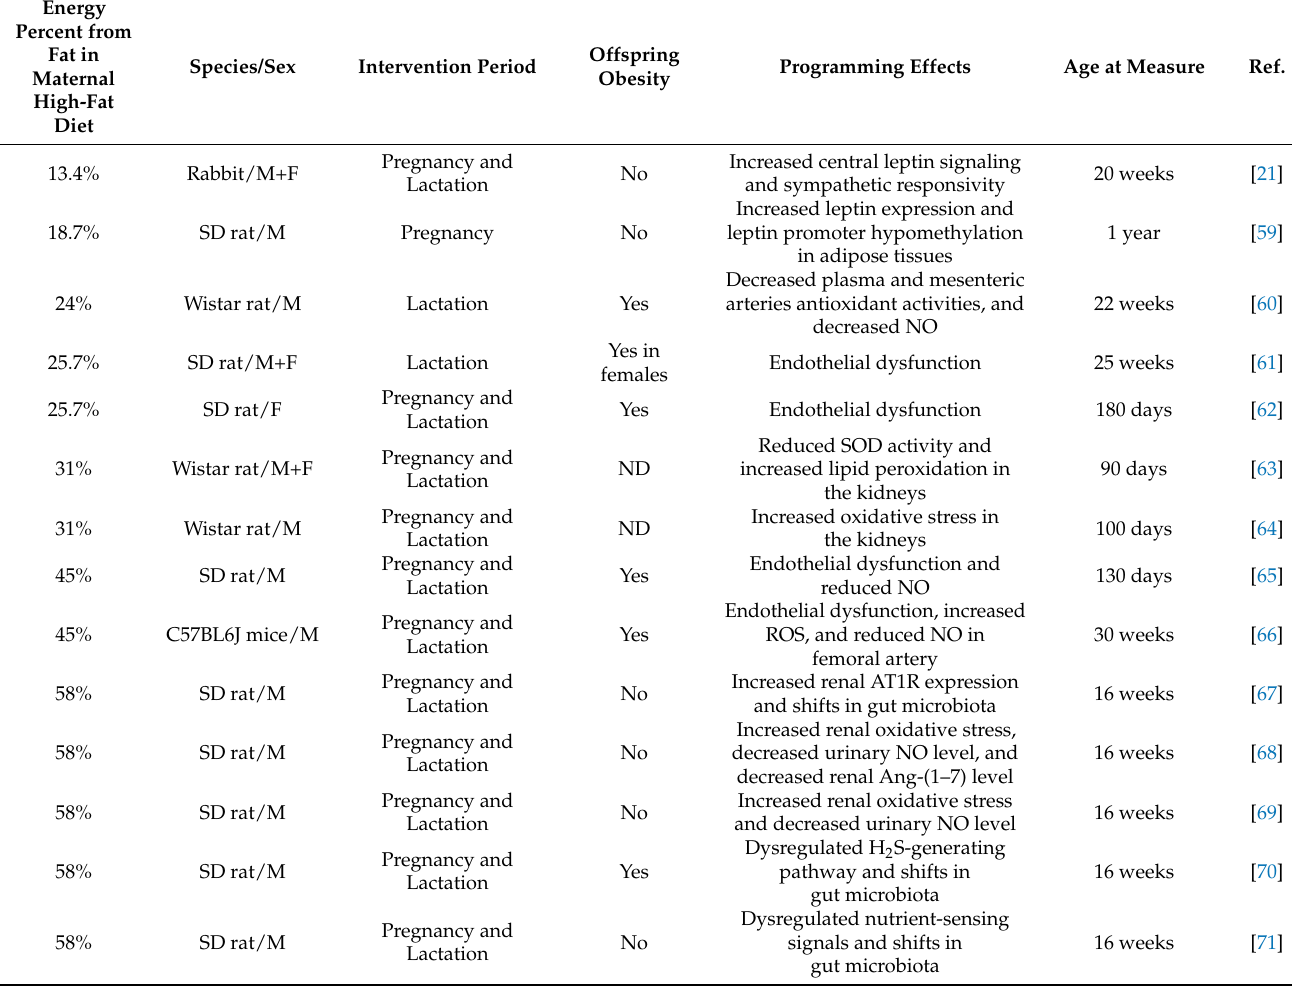
Table 1. Programming effects of maternal high-fat diet on offspring